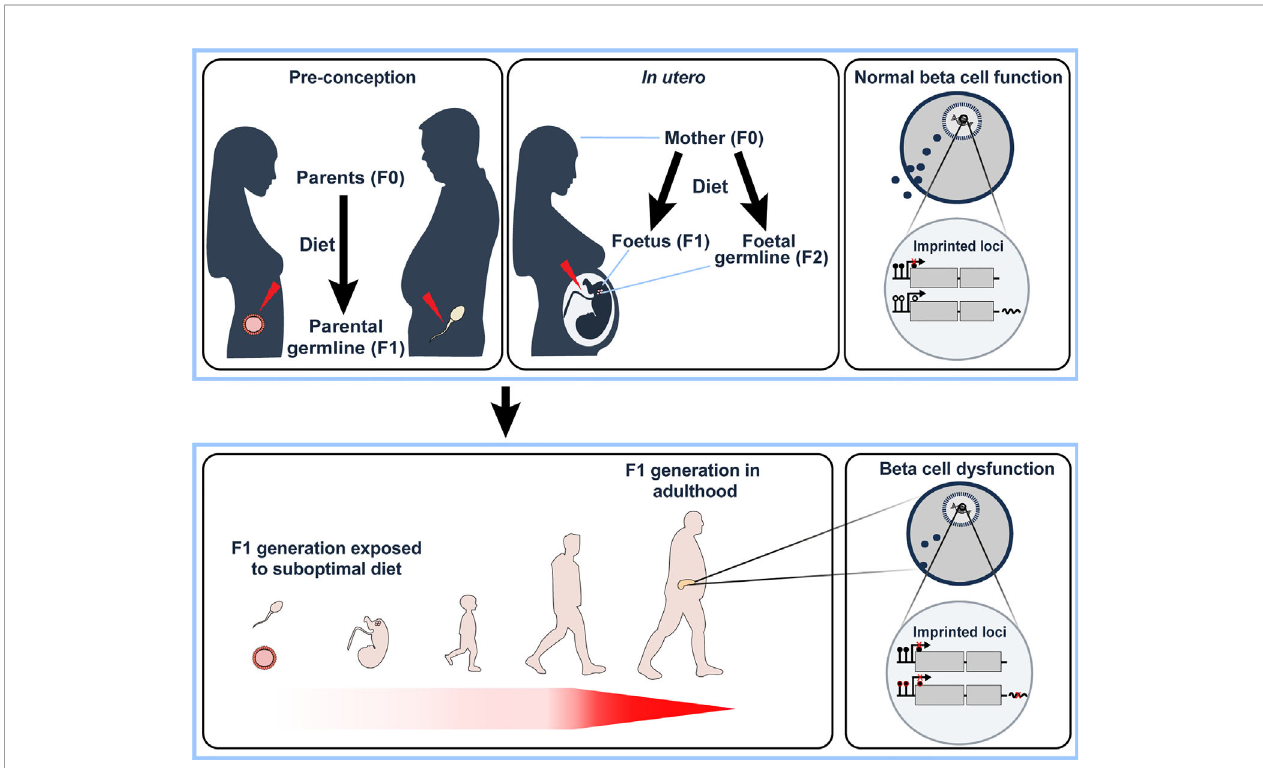
FIGURE 2 | Under- or overnutrition in fl uences imprinted gene expression not only in the individual (F0 generation) but also in the next generation (F1). This may occur indirectly via pre-conceptual changes in the germ cells (upper left panel) or via direct exposure in utero (and potentially the subsequent (F2) generation via direct exposure of foetal germ cells to nutritional alterations in utero , upper middle panel). F1 offspring that have been directly or indirectly exposed to a suboptimal nutritional status in early development have been shown to develop beta cell dysfunction in adulthood (lower left panel). In the F0 generation, overnutrition has been shown to alter imprinted gene expression in pancreatic beta cells via changes in DNA methylation at key regulatory genomic regions. We therefore hypothesise that changes in nutritional status affects the monoallelic expression of imprinted genes that is observed in ‘ normal ’ conditions (upper right panel) via alterations to CpG methylation, with an example illustrated in the lower right panel (closed circles – methylated CpGs, open circles – unmethylated CpGs). With their known functional role in beta cells, deregulation of imprinted gene expression via the diet would, therefore, lead to beta cell dysfunction. It will be interesting to determine the relative contribution of imprinted gene deregulation on the observed beta cell dysfunction in the F1 generation due to nutritional status in the F0